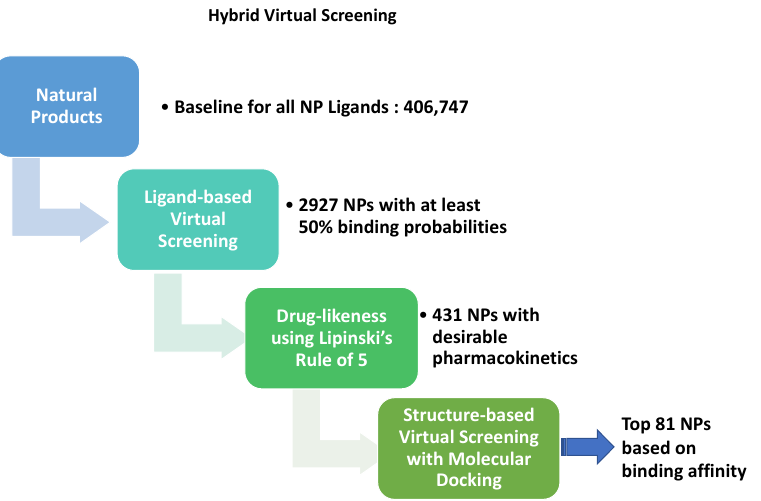
Figure 1. Overview of the results from LBVS and SBVS of NPs from the COCONUT